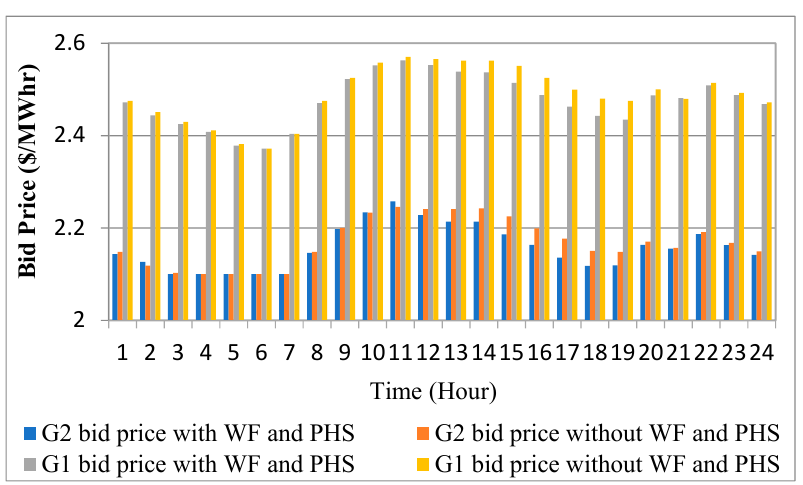
Figure 8. Bid price for G 1 and G 2 for 24 h scheduling period.